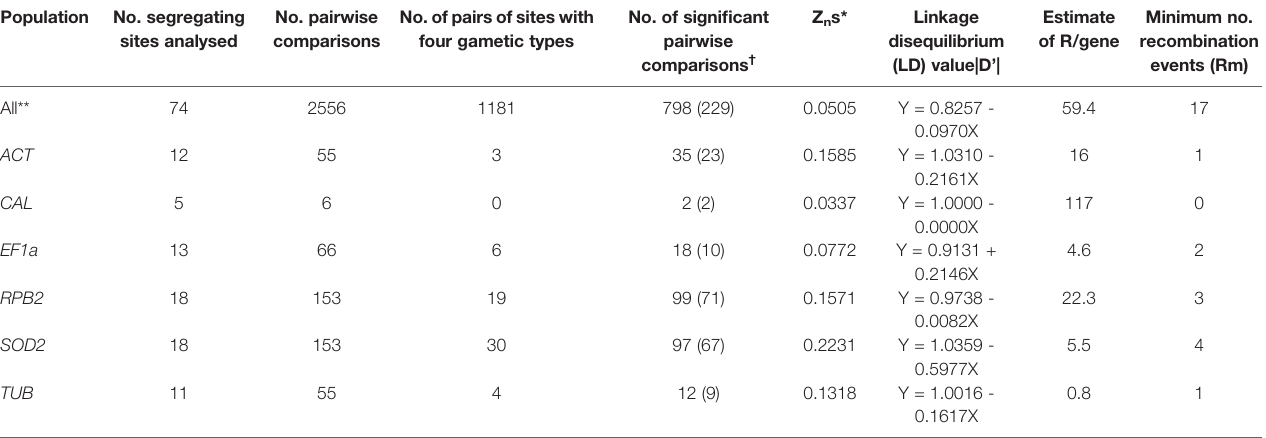
TABLE 3 | Pairwise interlocus linkage disequilibrium and recombination analysis of concatenated multilocus sequences from 188 Scedosporium aurantiacum strains. Population No. segregating sites